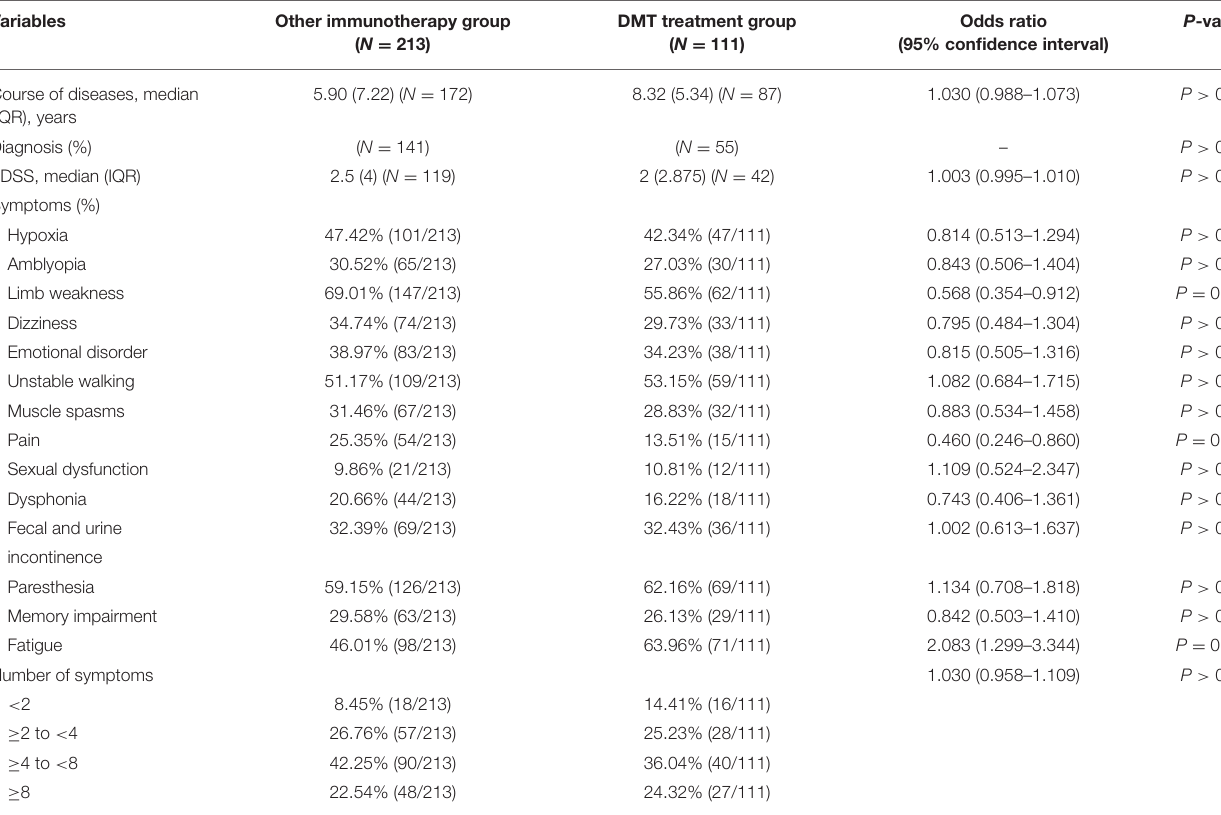
TABLE 5 | Disease characteristics of the DMT treatment group and other immunotherapy